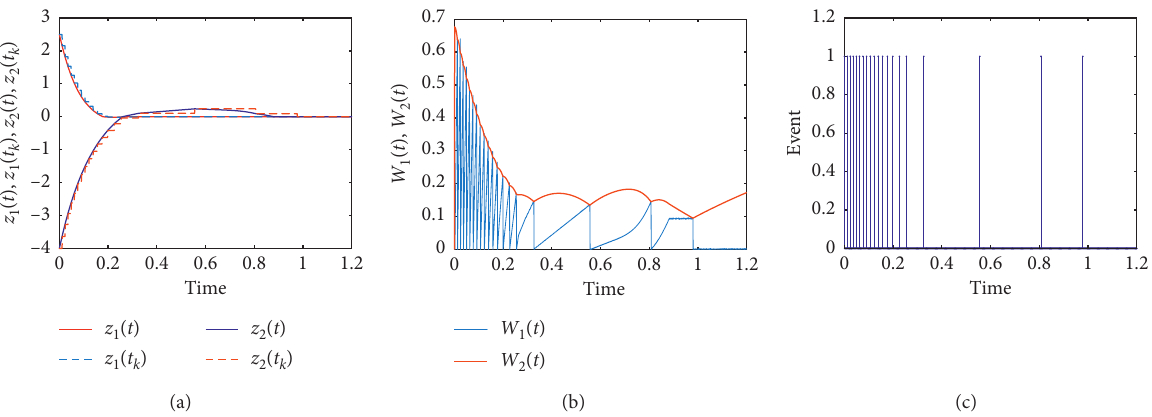
Figure 6: The dynamic event-triggering function (54) with ω � 0 . 75. (a) State trajectories of synchronization error system. (b) Trigger ( t ) � ‖ Δ z ‖ ( t ) � ζ ( t ) + ω ( η − H parameters W and W 1 1 2